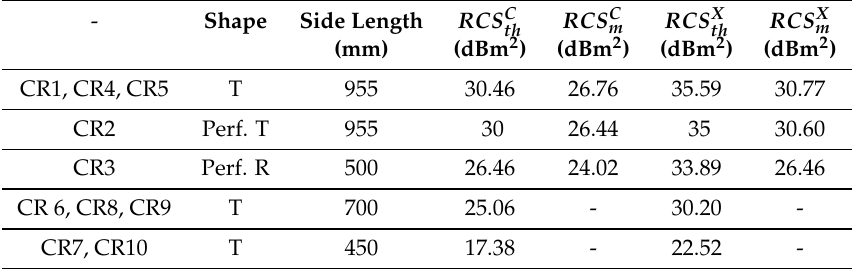
Table 1. Theoretical Radar Cross-Section RCS th and measured RCS m (dBm 2 ) in an anechoic chamber for different side lengths and shapes of CRs in C-band ( c ) with λ = 5.6 cm and X-band ( x ) with λ = 3.1 cm. T = Triangular, R = Rectangular, Perf. =